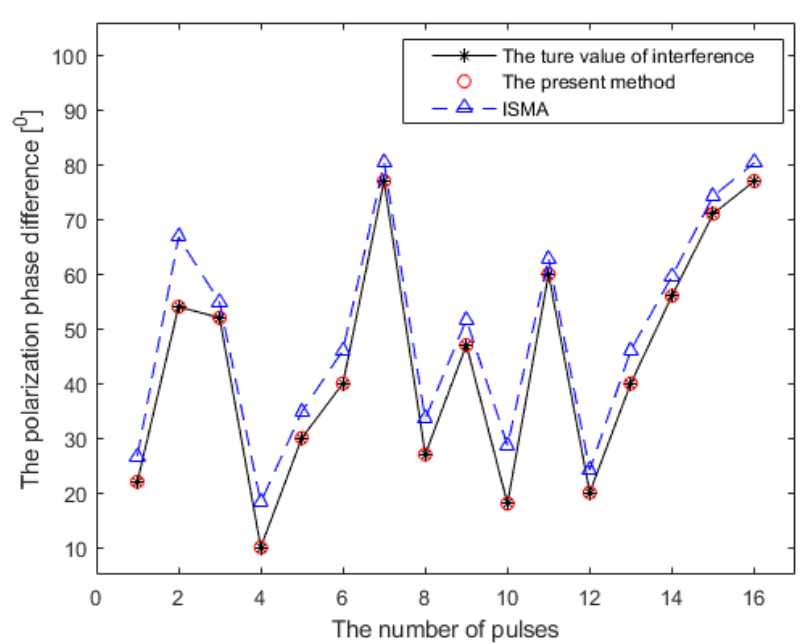
Figure 10. The estimation of the two methods under SNR 1 = − 10 dB.